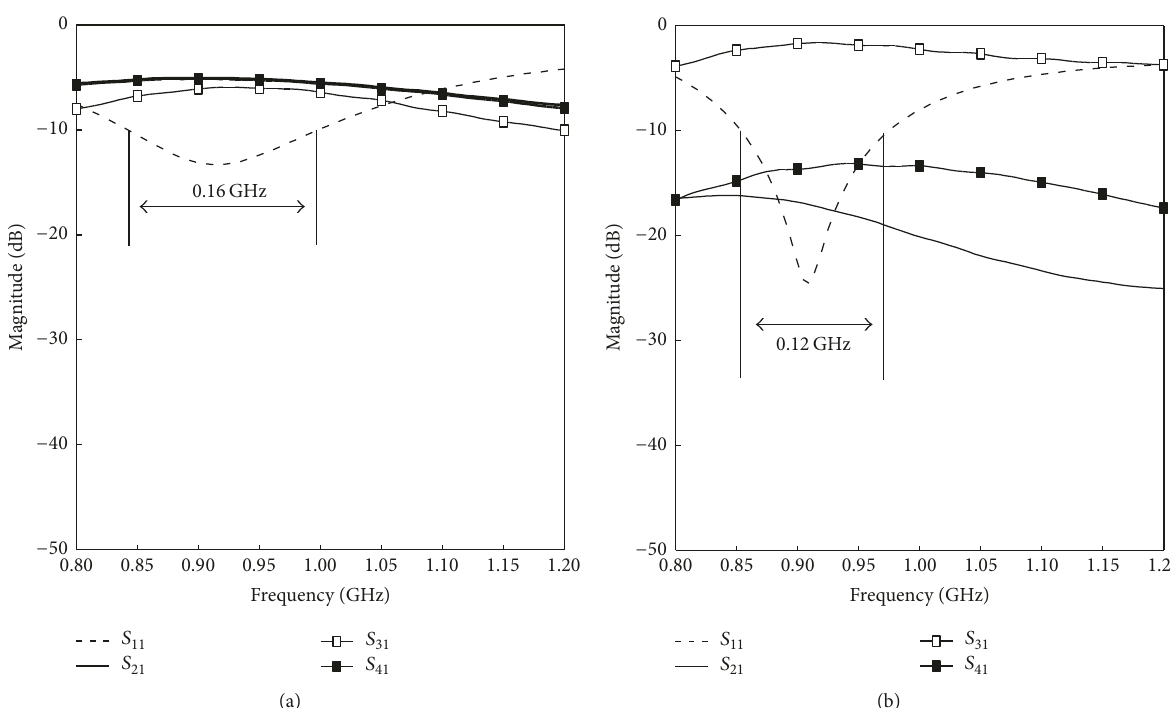
Figure 9: Measured 𝑆 -parameter result of the coupler using PIN diode and bias-T: (a) DC off and (b) DC on.